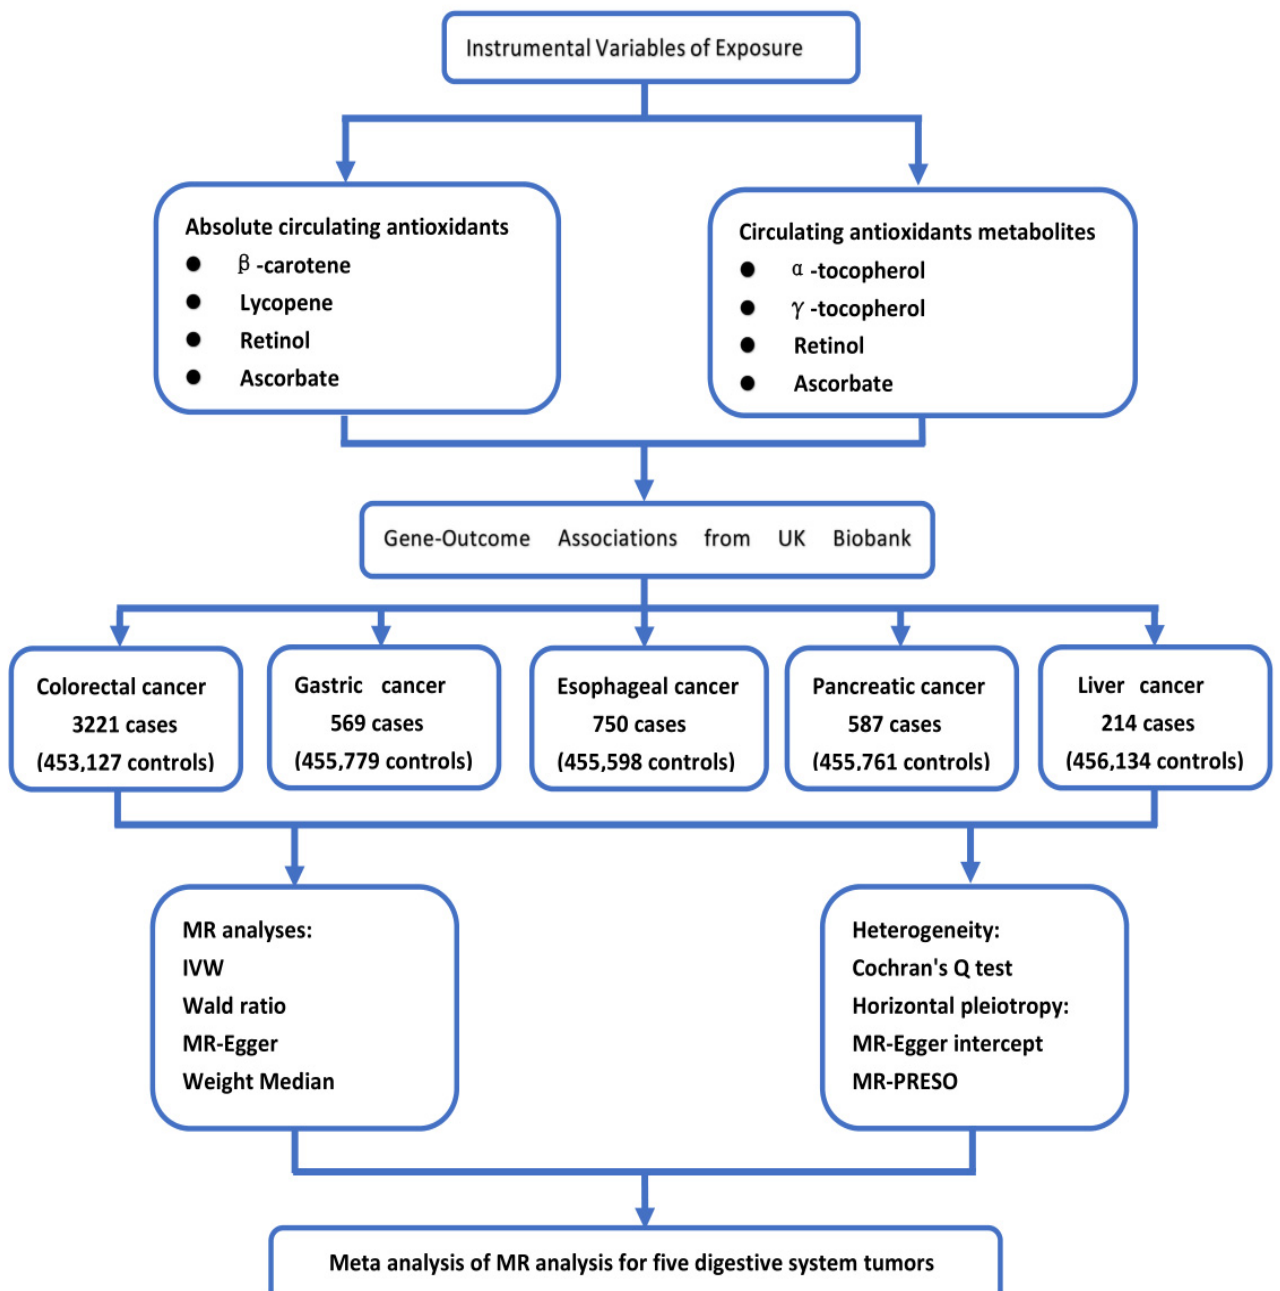
Figure 1. The flow chart of our study design.